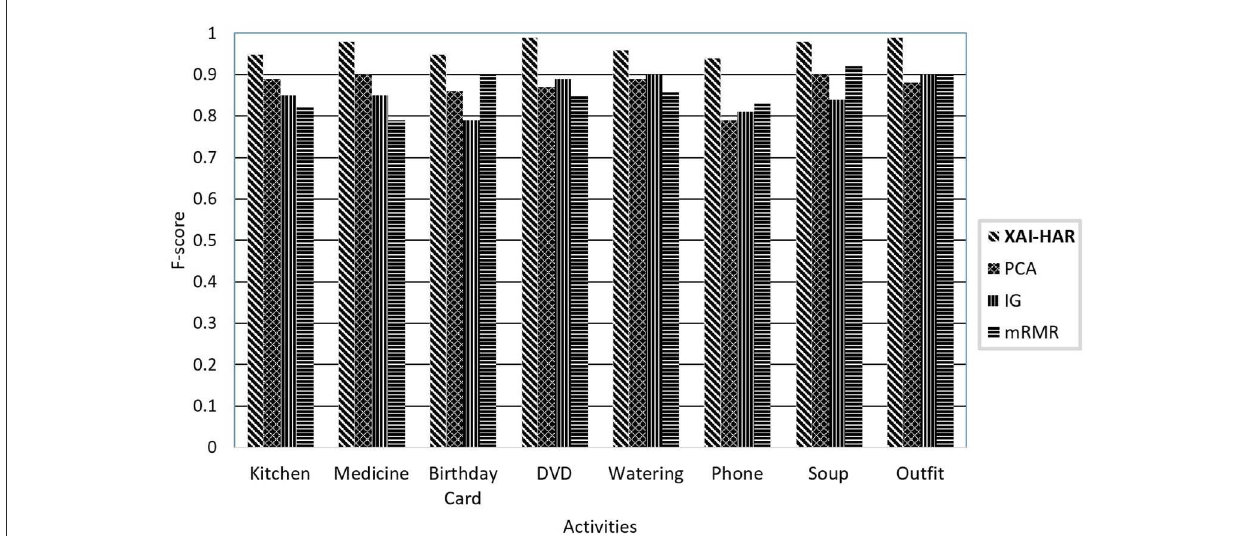
FIGURE5 Comparison of proposed XAI-HAR with feature selection methods such as PCA, mRMR, and IG in combination with RF for each activity of individuals with dementia.